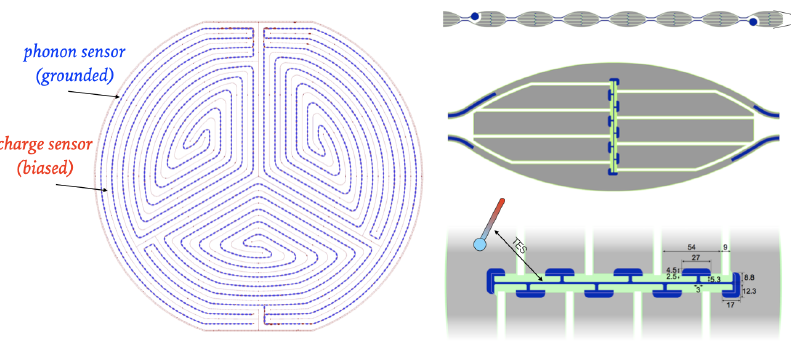
Figure 34: Schematic of a SuperCDMS iZIP detector. Left: Lines of ionization sensors (red) are interleaved between grounded phonon sensors (blue). Right: Each phonon sensor consists of an aluminum superconducting fin (grey) and a TES(blue.) Figure provided by the SuperCDMS